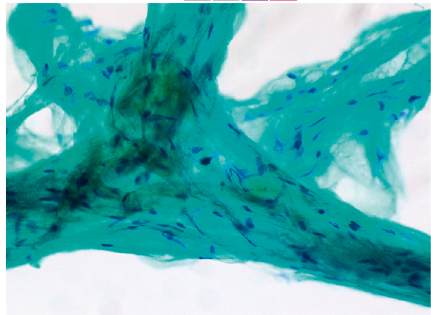
Figure 2: Fine needle aspiration cytology findings (Papanicolaou stain). There were a small number of mesenchymal cells with spindle-shaped